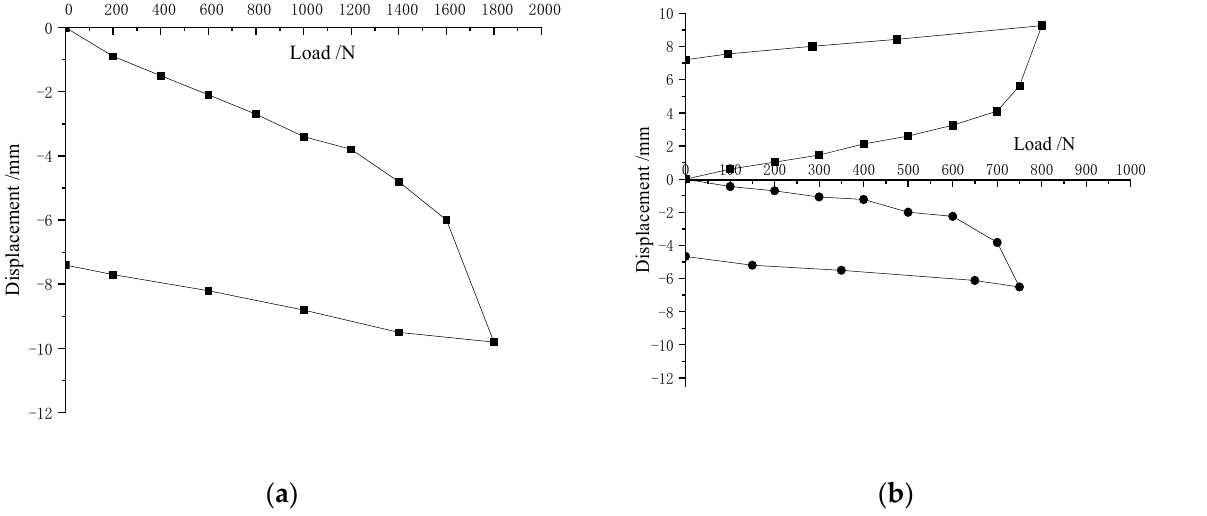
Figure 9. The test piles’ Q-s curves. ( a ) Traditional static pressure pile. ( b ) Self-balanced test pile. Under the above-mentioned self-balanced loading conditions, the theoretical analysis of the loading values at each level of the load box was used to determine the axial force at each position of the corresponding pile. Taking 200 N, 400 N, 600 N, 725 N (lower pile bearing capacity), and 758 N (upper pile bearing capacity), respectively. The comparison between the measured value and the theoretical value of the pile axial force under different loads is shown in Figure 10. The self-balanced theoretical axial loading calculation in each of the pile body’s points is relatively coincident with the measured data, and the maximum error of the bottom position of the pile does not exceed 5%. The load transfer law is gradually transferred from the loaded end to the far end. For the upper pile, the axial force curve bulges to the left. The load is transferred from bottom to top, and the closer the loading point is, the larger the axial force is, and it decays to the top of the pile. It can be seen from the linear density that the magnitude of the axial force gradually attenuates with the sparseness of the curve. The upper pile has a sparser curve from the loading point of 0 m to 0.15 m, and the attenuation is 46.67% to 60.85%, indicating that this part of the soil layer is subjected to higher loads. In addition, the upper and lower pile axial force curves at the same location far from the loading position overlap, indicating that the effect of the axial force has nothing to do with the loading direction.